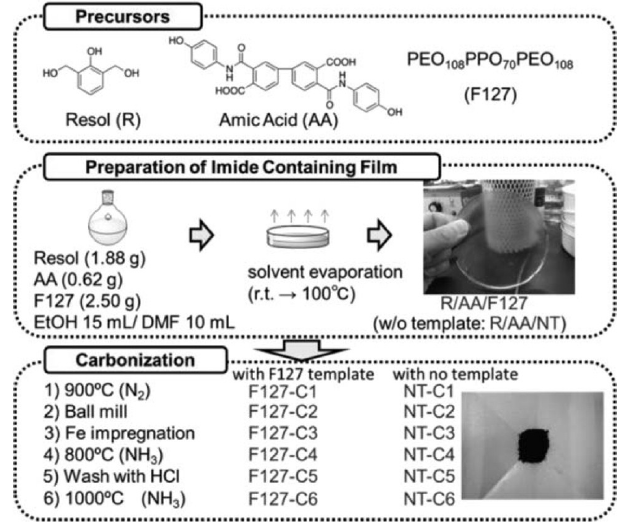
Figure 12. Schematic of the preparation of mesoporous Fe/N/C catalysts [56].